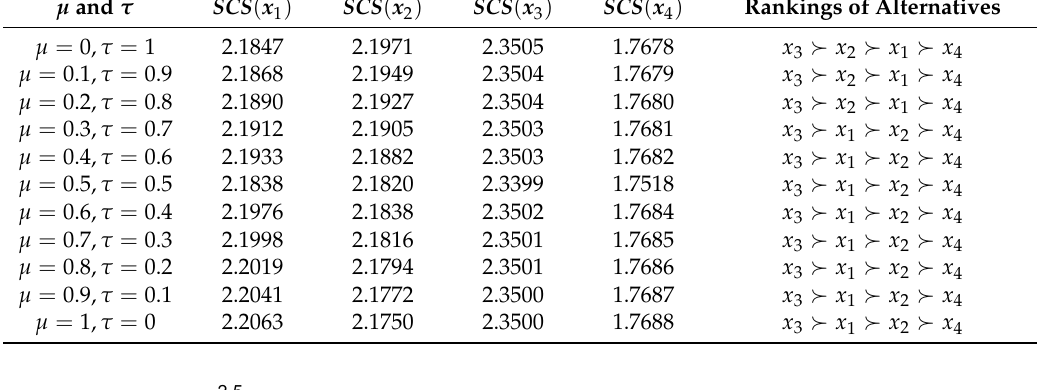
Table 5. Rankings of the alternatives with different values of μ and τ .